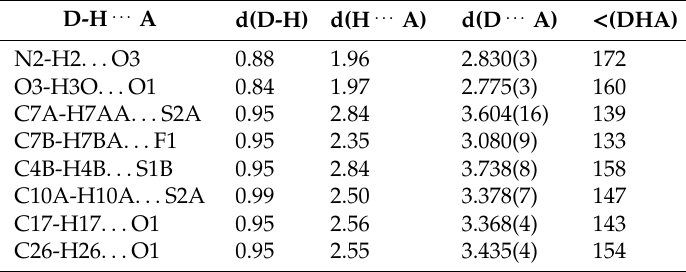
Table 2. Hydrogen bond distances (Å) and angles ( ◦ ) in 5